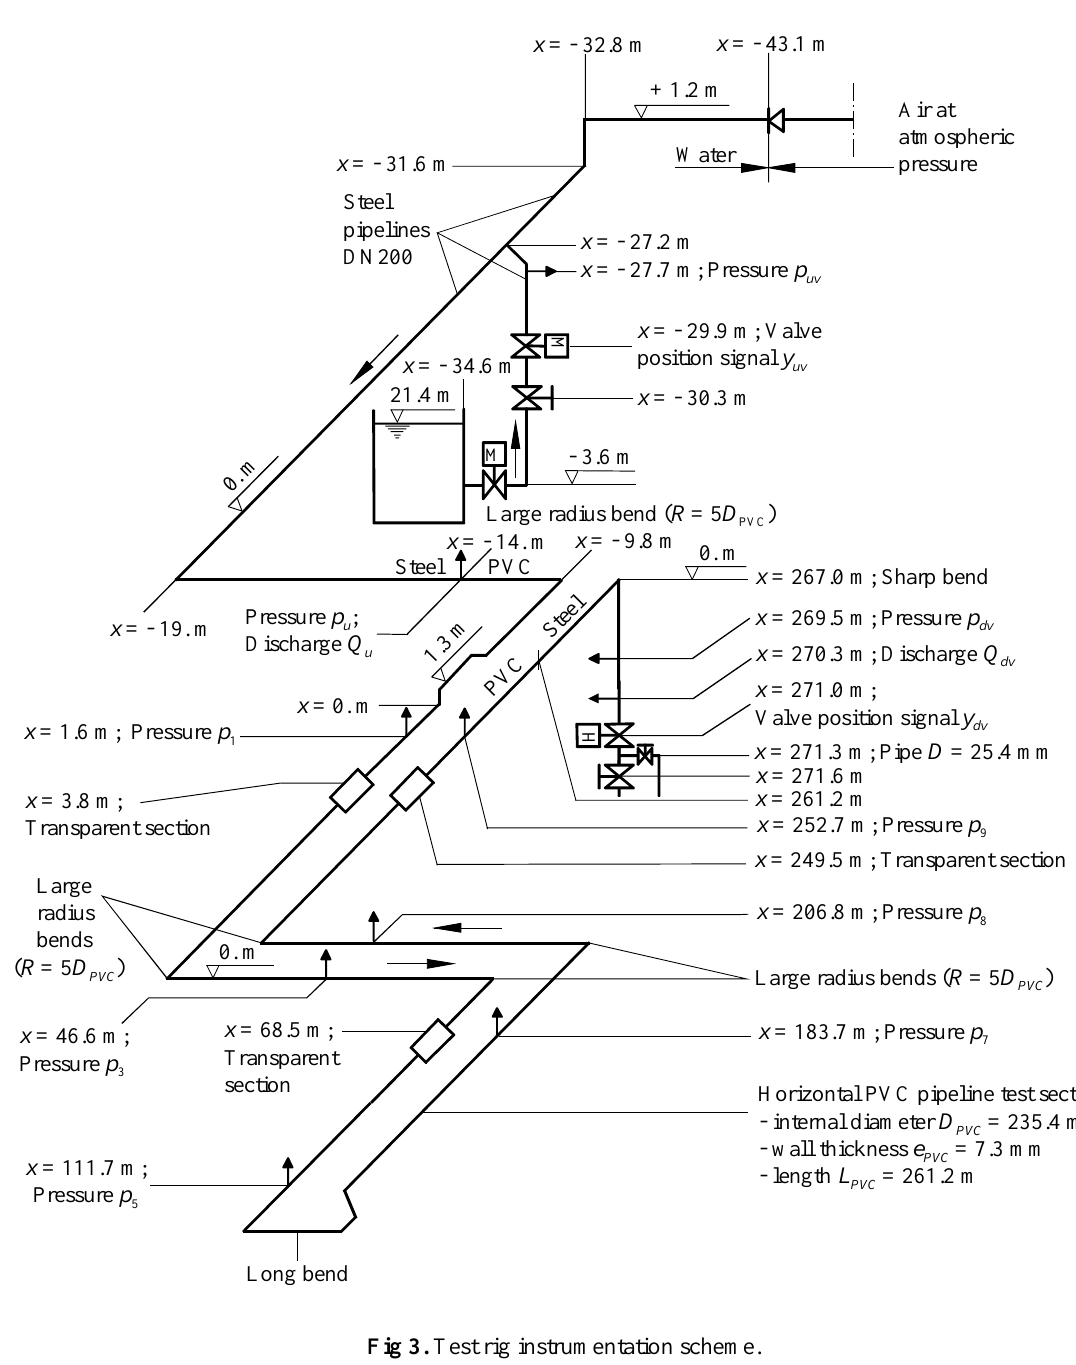
Fig 3. Test rig instrumentation